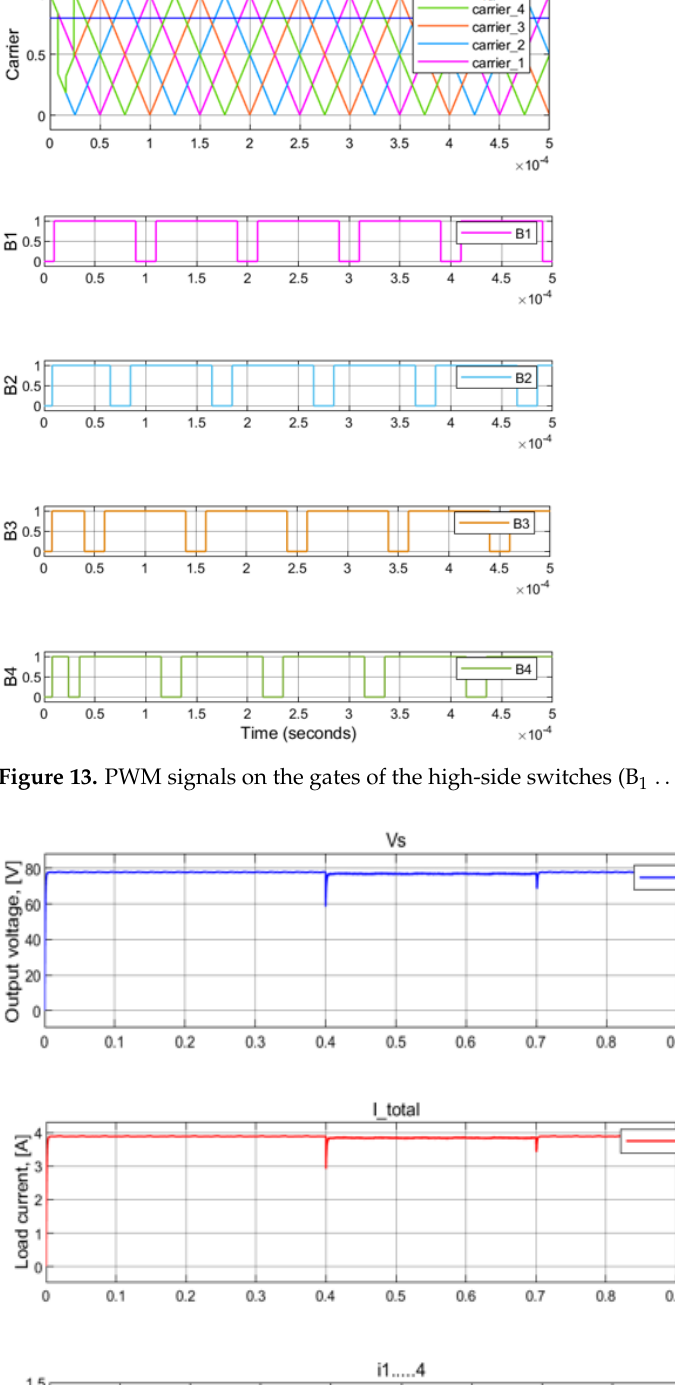
Figure 12. Simulation result of four interleaved carriers using DSA-PSC method.